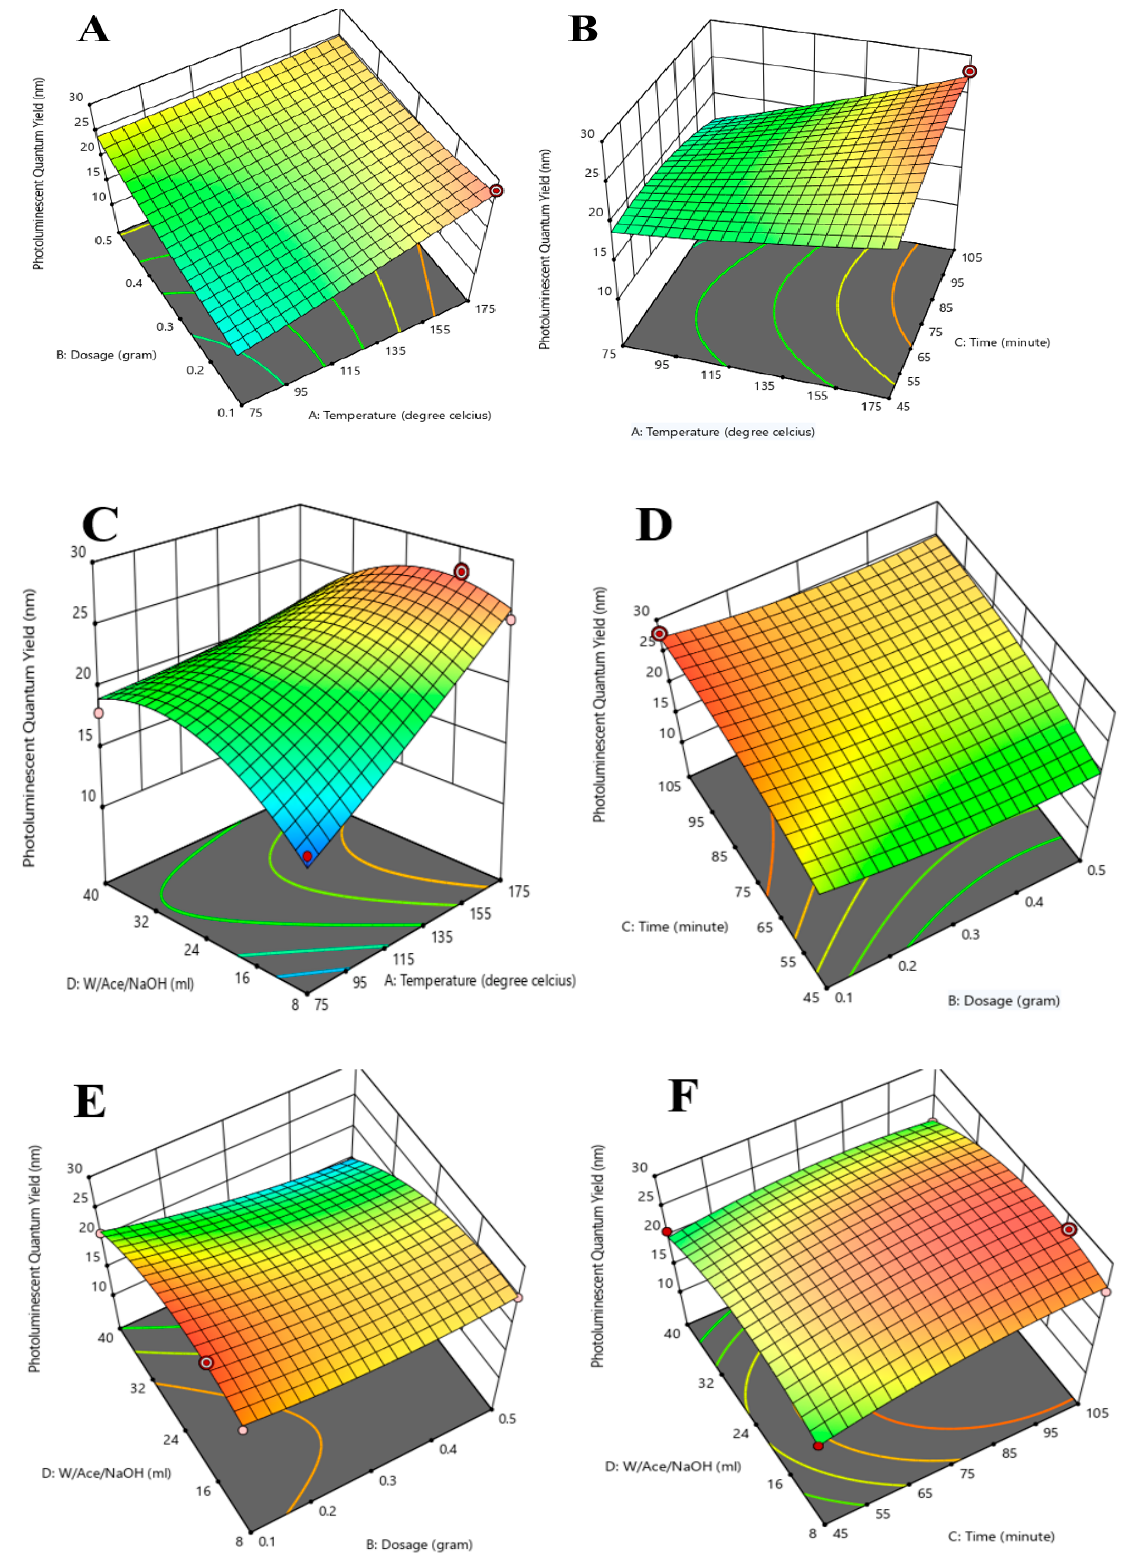
Figure 4. Experimental factors for 3D surface plots of tapioca powder conversion to fluorescent carbon dots.